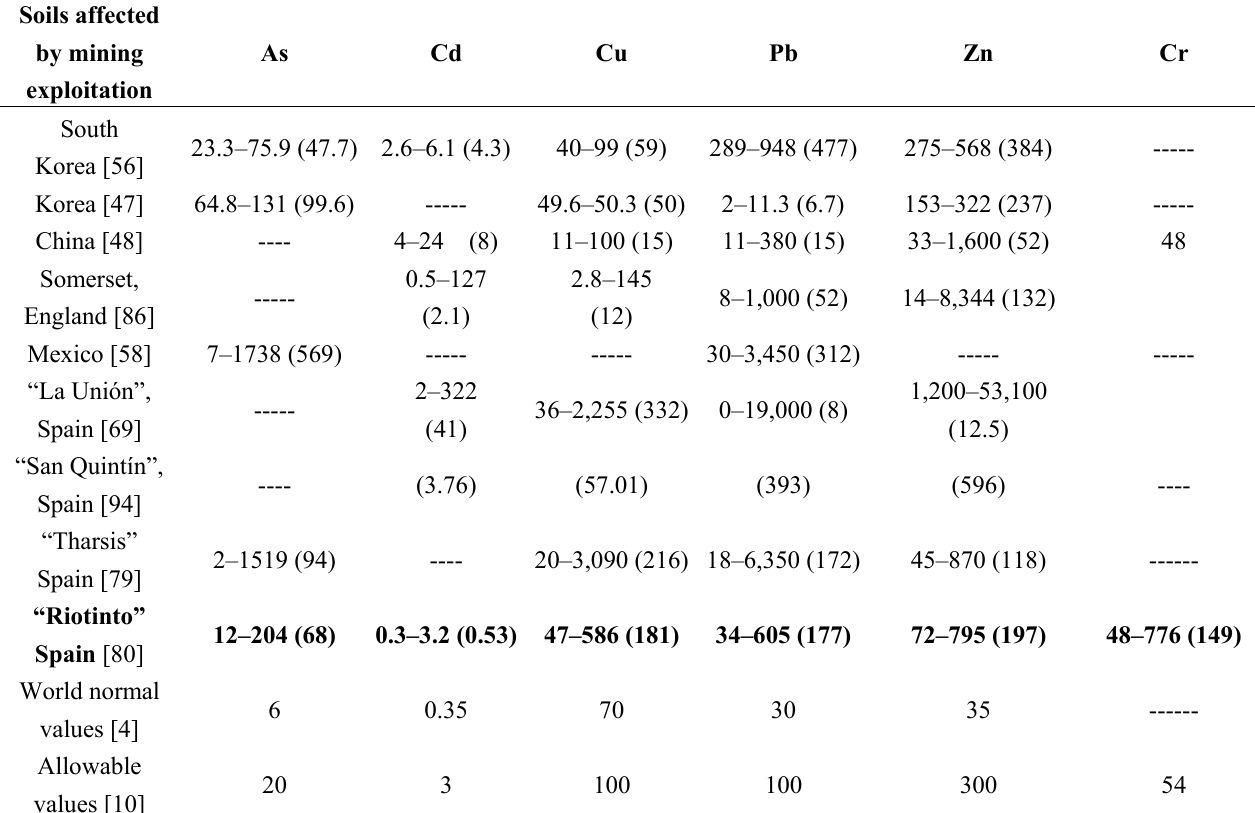
Table 7. Minimum and maximum values (mean) for some soils close to mining exploitations and reference values. Data in